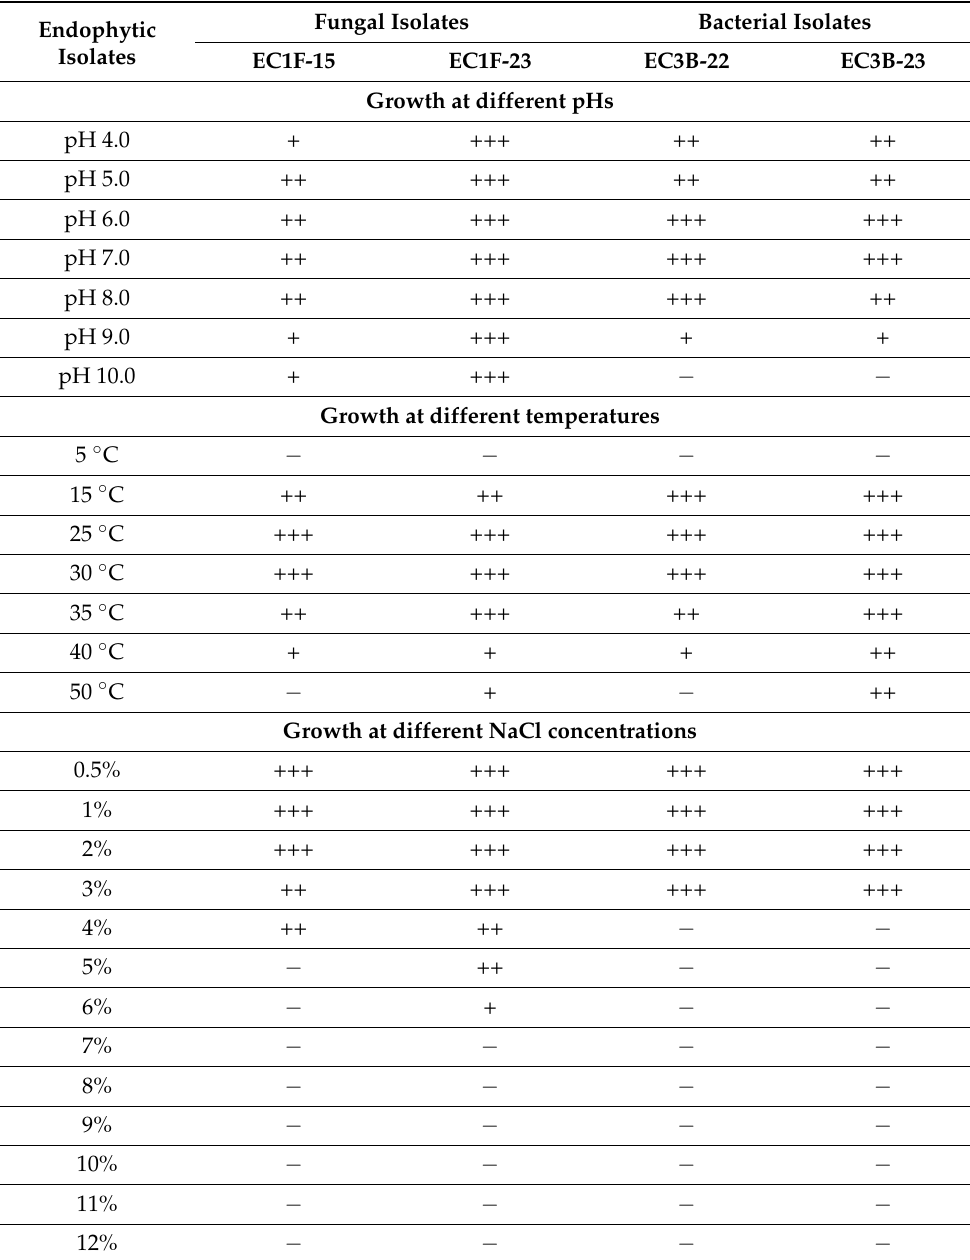
Table 4. Diverse abiotic stress stability is shown by